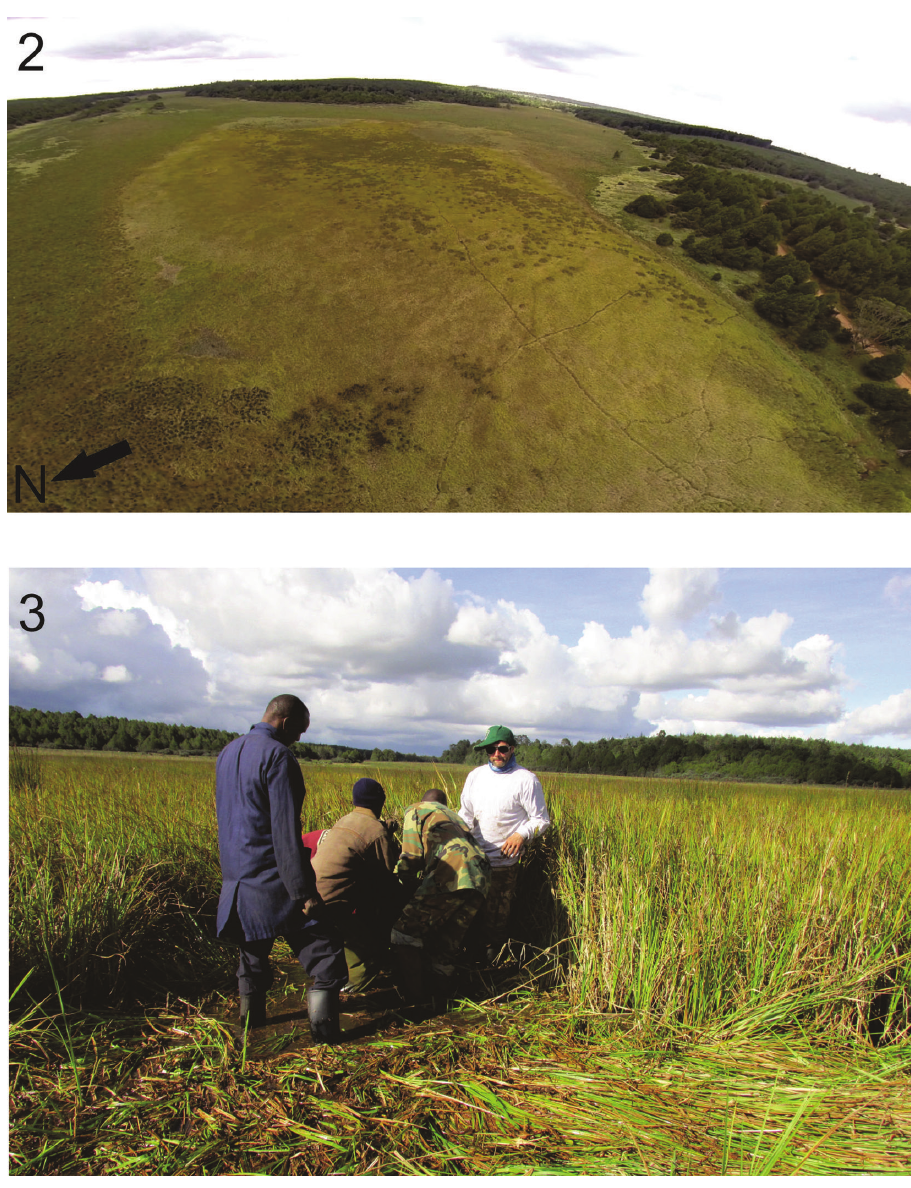
Figures 2–3. An wide angle aerial oblique photograph of Enapuiyapui wetland from the northwest facing southeast ( 2 ). Coring the center of the Cyperaceae-Poaceae wetland, April 2014 ( 3 ). area of the swamp to target for coring the complete stratigraphy, the wetland was first probed using fiberglass rods with multiple 1-m-long rod extensions. A 537 cm stra- tigraphy was collected near the swamp center using a hand pushed Russian D-shaped corer in 50 cm drives with approximately 10 cm overlapped sections (Figure 3).